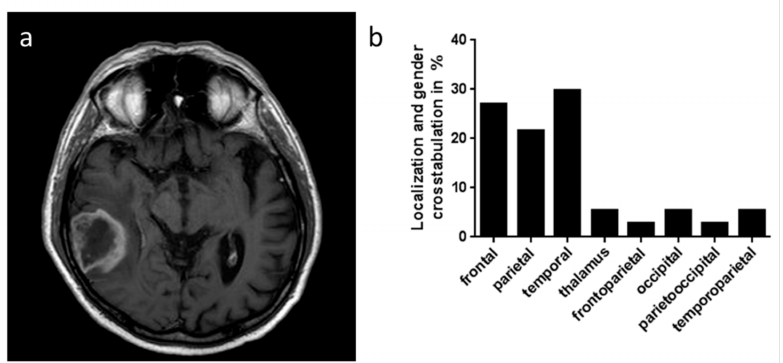
Figure 1. ( a ) T1-weighted gandolinium enhanced cranial axial image with a typical glioblastoma (GB) in the right dorsal temporal lobe. ( b ) Frequency of localization of GB in % is shown. Most tumors were found in the frontal, parietal, and temporal lobe of the patients.